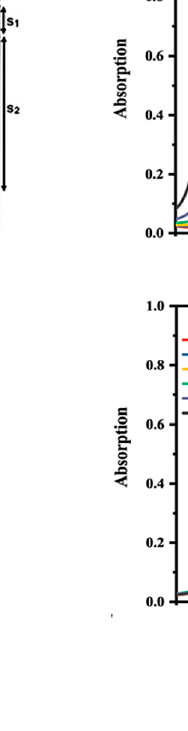
( b ) Figure 25. ( a ) Structure of graphene-based infrared band absorber and ( b ) corresponding absorption spectra of graphene nanodisc and L-type single-layer graphene array at different Fermi levels [63].